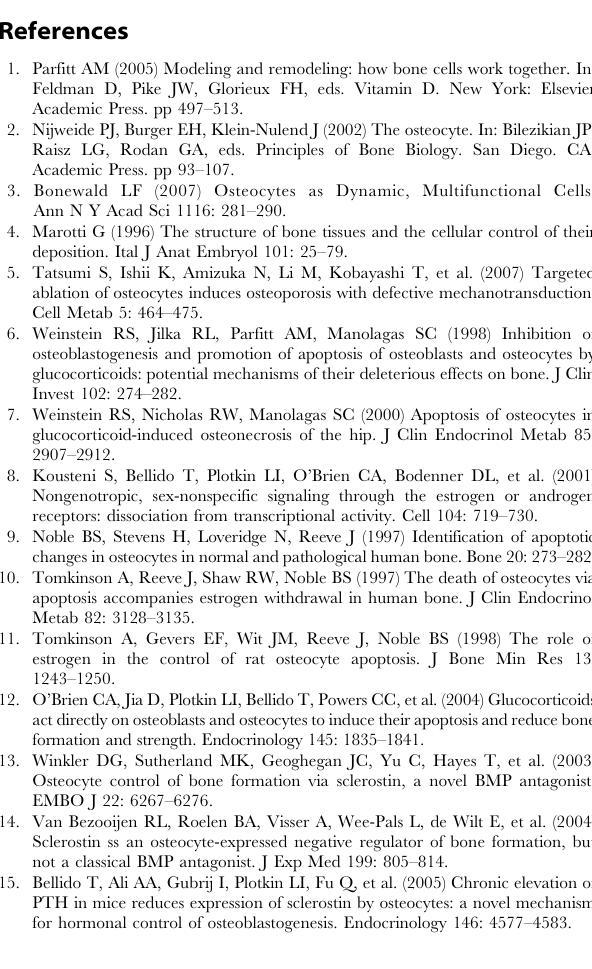
Figure S5 Osteoblast and Osteoclast Markers are Increased in DMP1-caPTHR1 Transgenic Mice (A) Quantitative RT-PCR analysis of osteoblastic genes in tibia from 9-week-old DMP1- caPTHR1 transgenic mice and wild type littermates. Bars represent the mean 6 SD of 3 mice. *p , 0.05 vs. WT mice. (B) In situ hybridization of tibia sections from 10.5-week-old mice with the indicated probes. (C) Quantitative RT-PCR of osteoclast- specific genes in tibia of 9-week-old mice. Bars represent the mean 6 SD of 3 mice. * p , 0.05 vs. WT mice. Found at: doi:10.1371/journal.pone.0002942.s005 (1.03 MB TIF) Text S1 Found at: doi:10.1371/journal.pone.0002942.s006 (0.03 MB DOC) Found at: doi:10.1371/journal.pone.0002942.s007 (0.04 MB